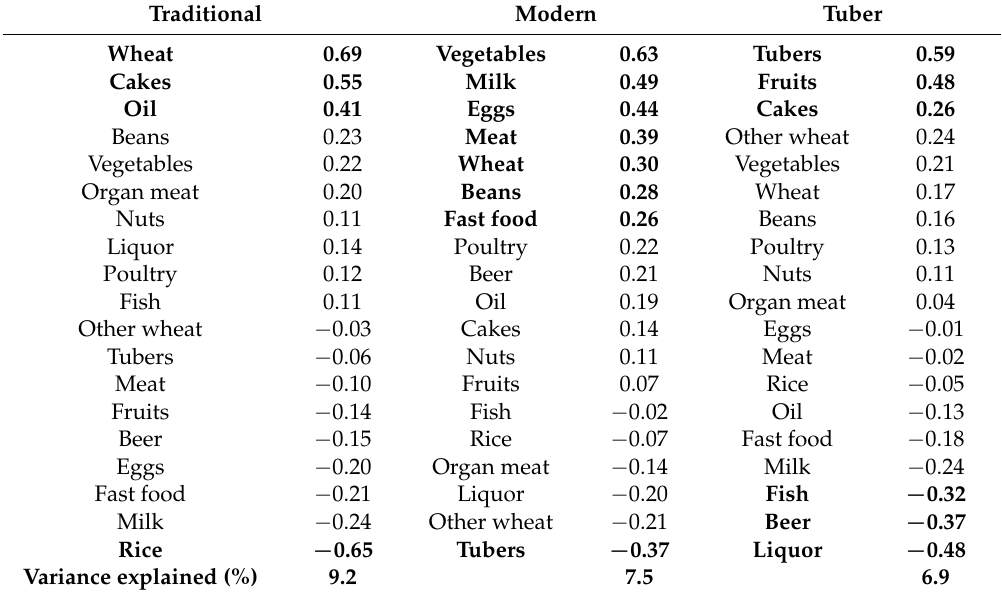
Table 2. Factor loadings for three dietary patterns among adults in Southwest